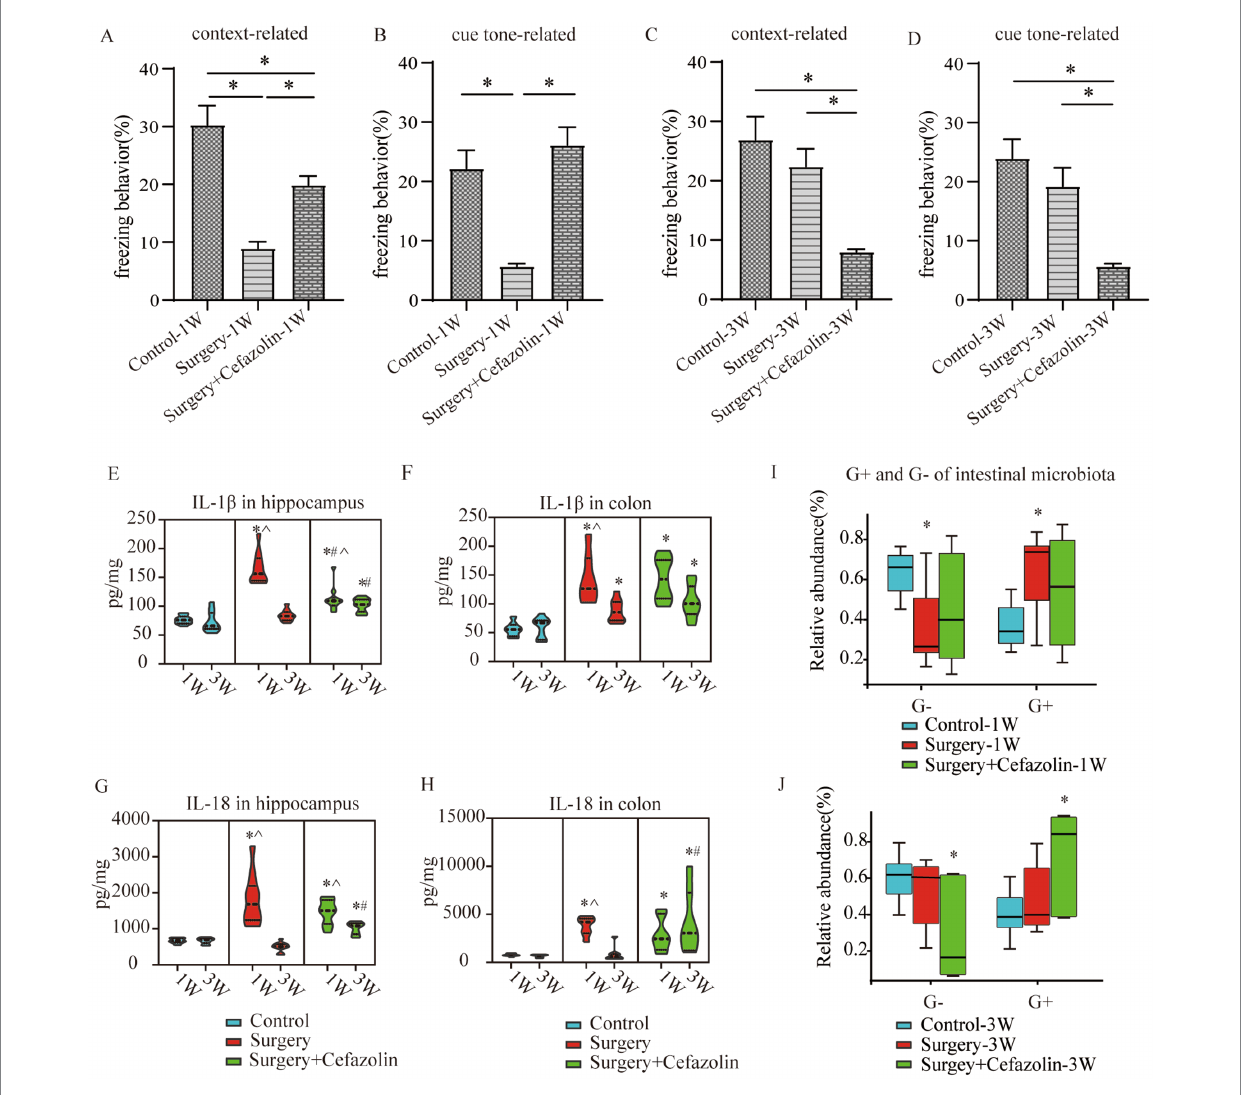
FIGURE 2 Surgery/anesthesia stress-induced and perioperative cefazolin-induced gut dysbacteria, inflammation, and cognitive dysfunction, respectively. (A,B) Surgery/anesthesia stress decreased context-related (q = 9.737, p < 0.0001) and cue tone-related (q = 6.635, p = 0.0002) freezing behavior at 1 week, while cefazolin could improve context-related (q = 4.996, p = 0.0041) and cue tone-related (q = 8.229, p < 0.0001) freezing behavior ( n = 10, ANOVA with Tukey’s multiple comparisons test). (C,D) At 3 weeks after surgery, surgery/anesthesia stress-induced freezing behavior recovered, while cefazolin decreased context-related (vs. control, q = 6.671, p = 0.0002; vs. surgery, q = 5.078, p = 0.0036) and cue tone-related (vs. control, q = 7.029, p < 0.0001; vs. surgery, q =